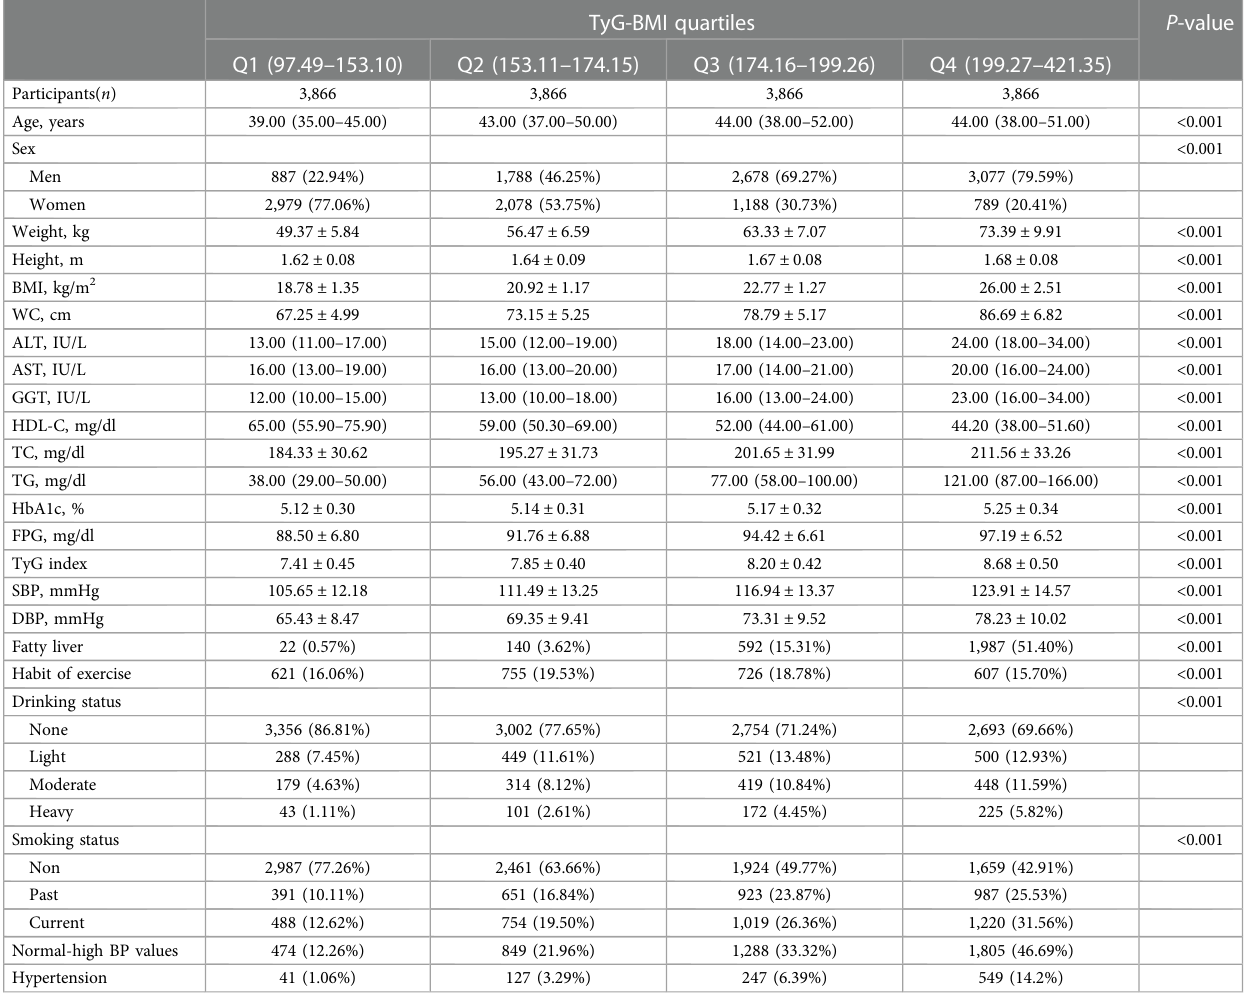
TABLE 1 Clinical characteristics of the study population according to TyG-BMI